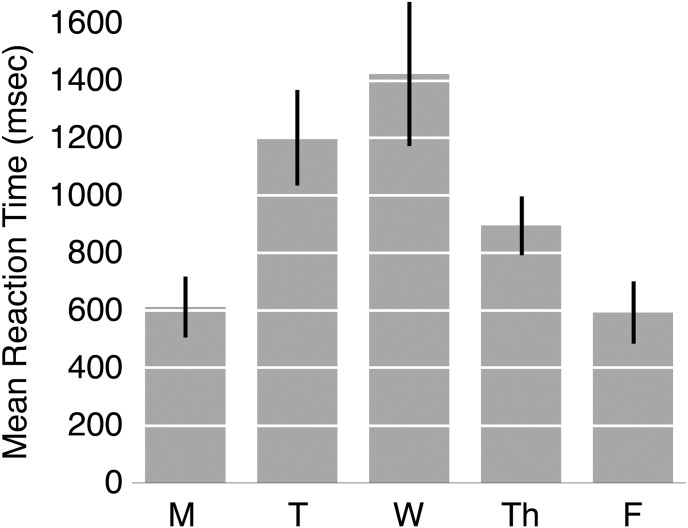
Mean correct reaction times (msec) as a function of weekday for the production task in Study 2.Error bars show SEM.